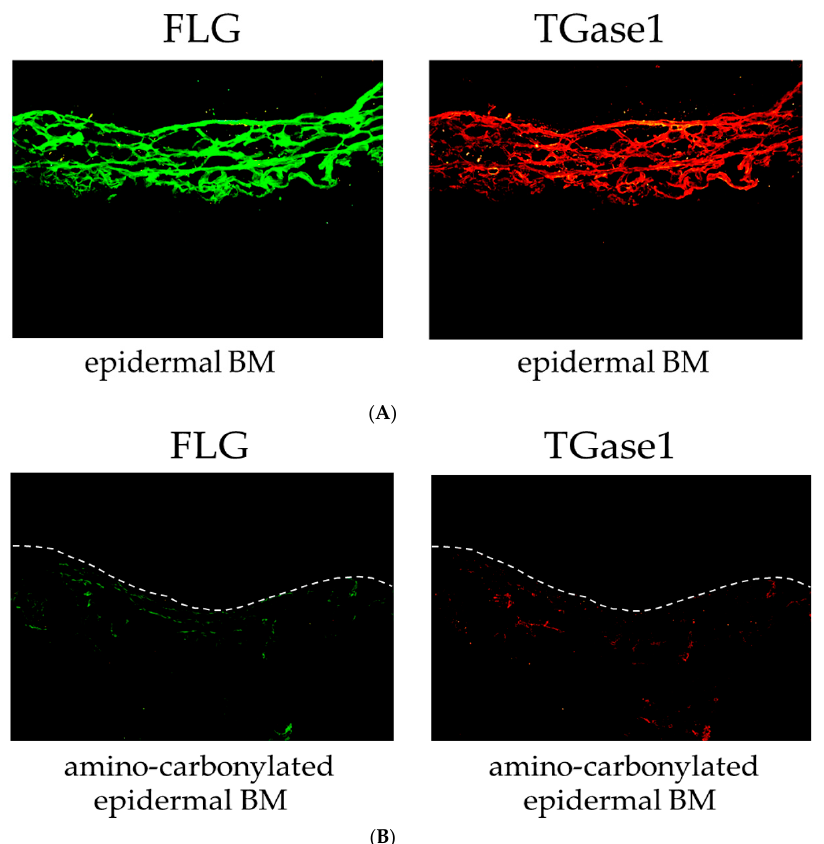
Figure 3. Effects of amino carbonylation of the epidermal BM on FLG and TGase1 protein levels in a human epidermis model. The 3D models of human epidermis were cultured on epidermal BM ( A ) and BM treated with 5 mmol/L glyceraldehyde for 4 days ( B ). FLG (green) and TGase1 (red) localized to the cell membrane in the stratum corneum layer. Dotted lines show the boundary between the stratum corneum layer and